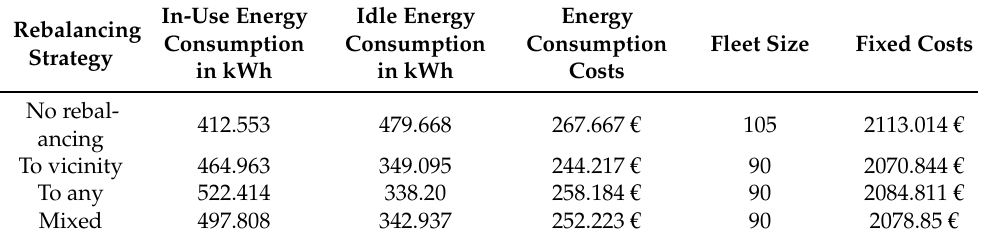
Table 6. Fixed and variable costs for the different rebalancing options.